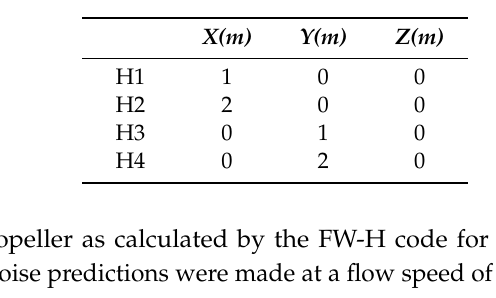
Figure 14. Location of hydrophones. Table 4. Coordinates of Table 4. Coordinates of hydrophones.